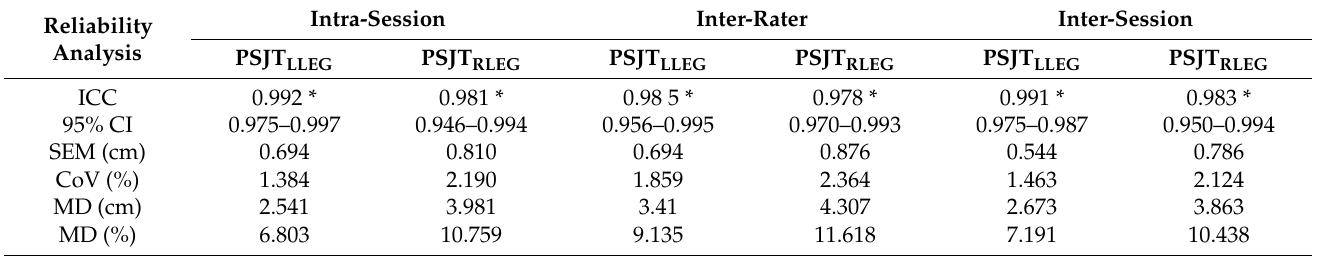
Table 4. Interclass correlation coefficients (ICC), 95% confidence interval (95% CI), standard error of measurement (SEM), coefficient of variation (CoV), and minimal difference (MD) values of the intrasession, interrater, and intersession reliability analysis of the PSJT measures for EGA ( n = 15).